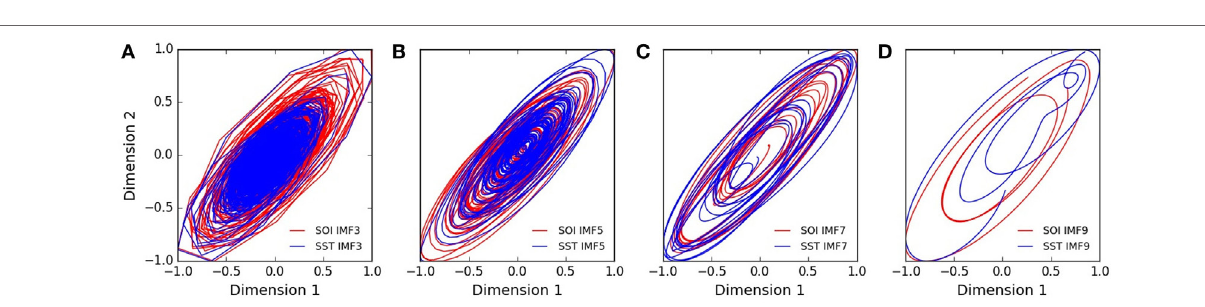
FigUre 3 | Trajectories of southern oscillation (SOI), and sea surface temperature (SST) in phase plane. (a–D) show the trajectories of intrinsic mode functions with different timescales. The geometries of the trajectories of SOI and SST are similar in state